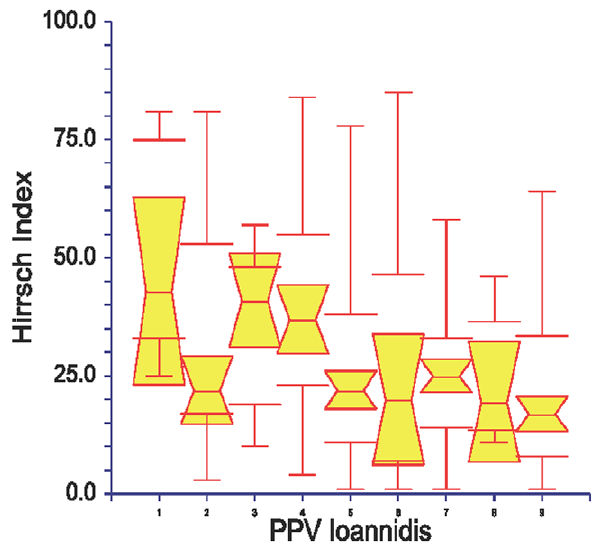
Figure 1. Hirsch-index and positive predictive value of research findings. On the vertical axis are plotted the Hirsch Index estimated using Google Scholar. On the horizontal axis are plotted the positive predictive value (PPV) of the conclusions of research findings, classified in 9 categories according to Ioannidis [4]: 1) Adequately powered randomized trial (RCT) with little bias and pre-study data (median h-I=43); 2) Confirmatory meta-analysis of good quality RCTs (h-I=22); 3) Meta-analysis of small inconclusive studies (h-I=41); 4) Underpowered, but well-performed phase I/II RCT (h-I= 37); 5) Underpowered, poorly performed phase I/II RCT (h-I=22); 6) Adequate- ly powered exploratory epidemiological study (h-I=20); 7) Underpow- ered exploratory epidemiological study (h-I=25); 8) Discovery-oriented exploratory research with massive testing (h-I=20); and 9) As 8, but with more limited bias (h-I=17). Using Dunn’s multiple comparisons test, the medians were significantly different between 1 and 5,7 and 9; 2 vs 9; 4 vs 5; 6 vs 7 and 9. Box plots were medians with 95% confidence intervals and extremes values.